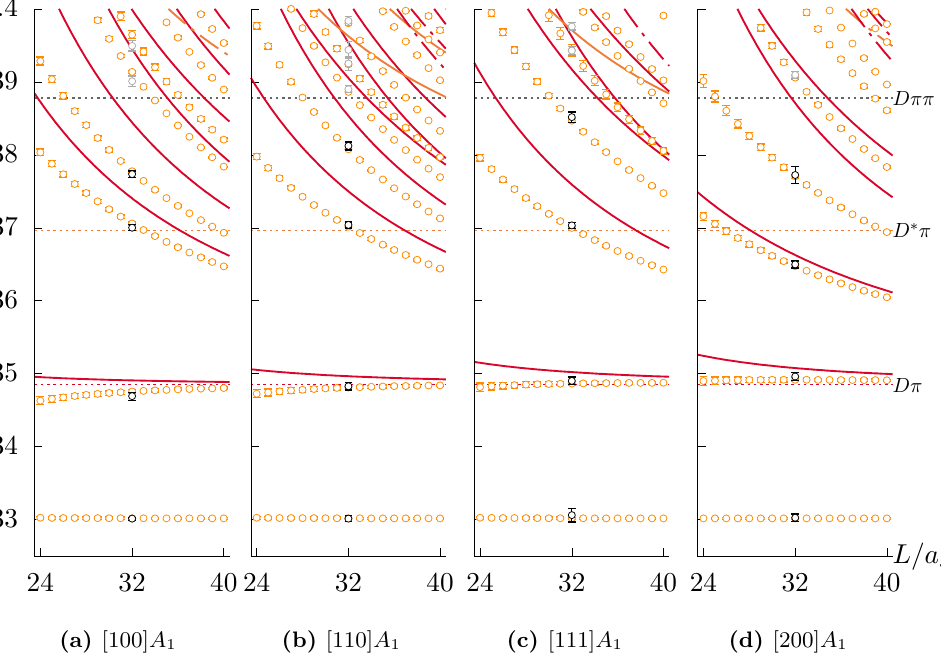
Figure 6. As figure 5, but for the moving frame A 1 irreps.